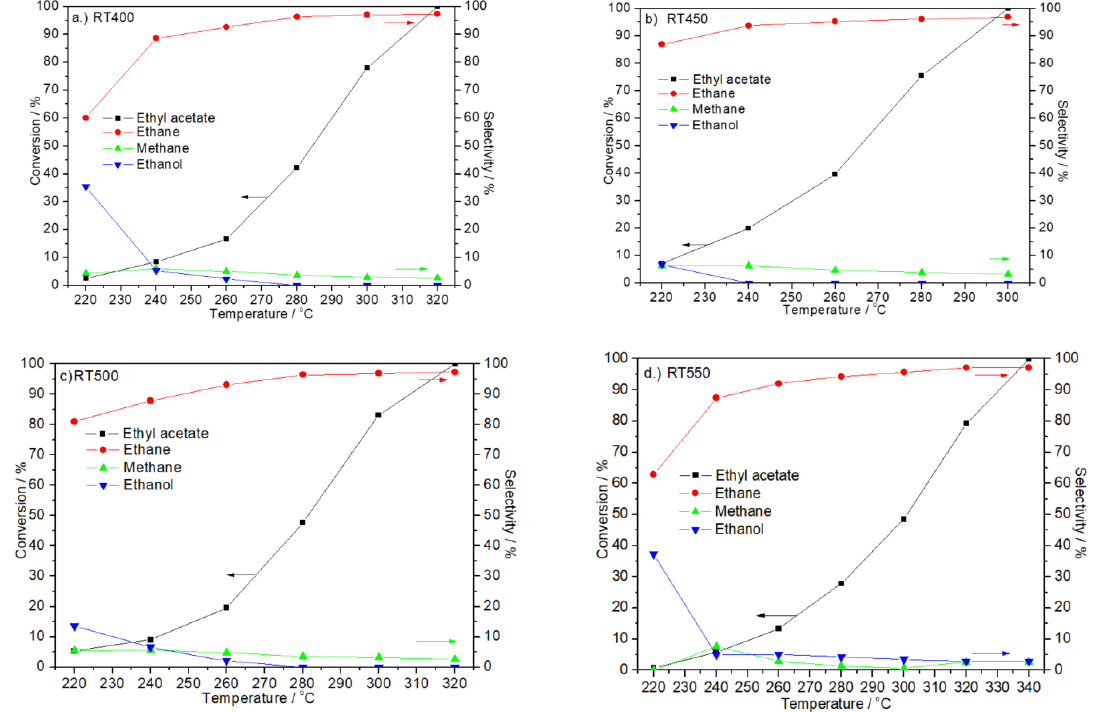
Figure 7. Influence of reduction temperature on the ethyl acetate hydrodeoxygenation conversion and products selectivity over the RTx catalysts. ( a ) RT400, ( b ) RT450, ( c ) RT500, and ( d ) RT550.